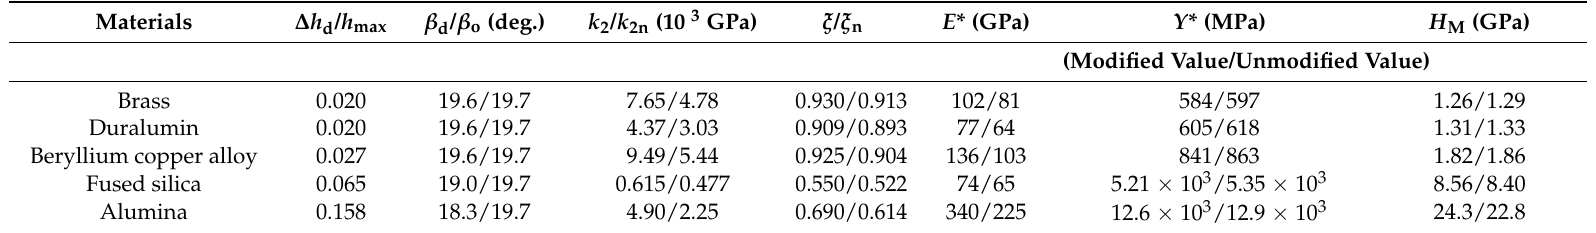
Table 1. Effect of elastic deformation of diamond indenter on mechanical property